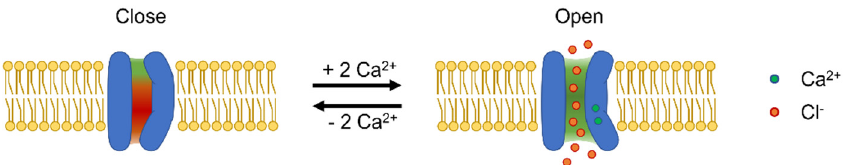
Figure 3. TMEM16A close and open conformation diagram. Diagrammatic representation of a single TMEM16A channel pore and related gating mechanisms. Ca 2+ binding induces opening of the steric gate in TM6 and attenuation of the electrostatic gate. The movement of the TM6 helix during gating is represented as a tilt of the inner portion of the pore and opening of the outer pore. The green and red backgrounds depict positive and negative electrostatic potentials in the pore, respectively.